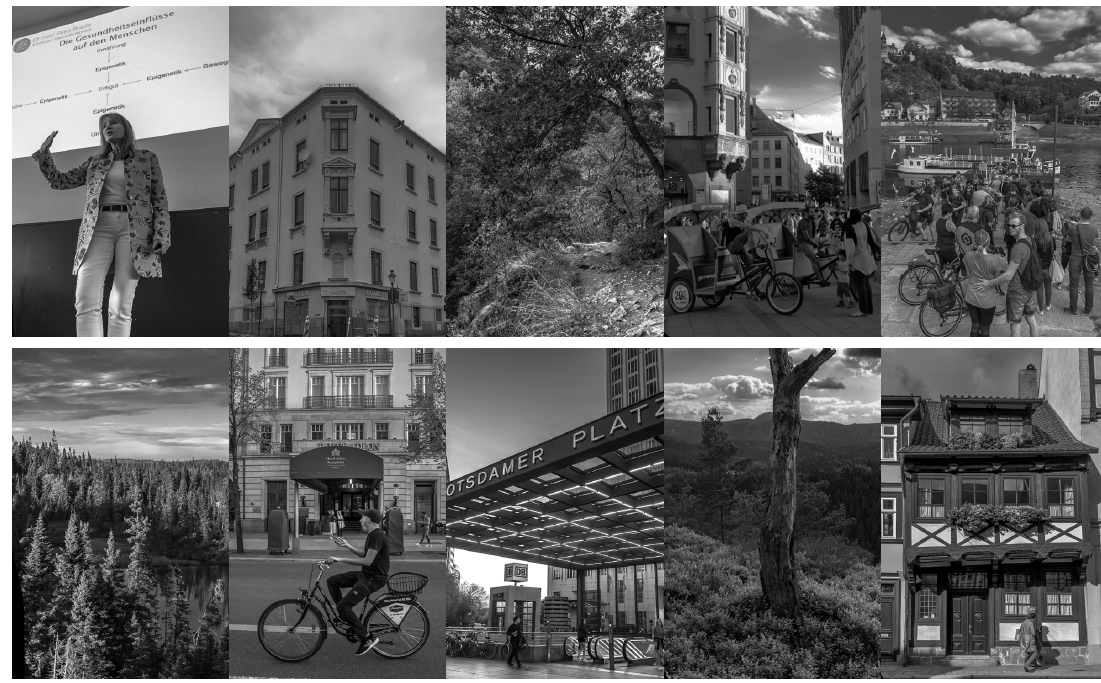
Figure 9. Some representative images in the Flickr1024